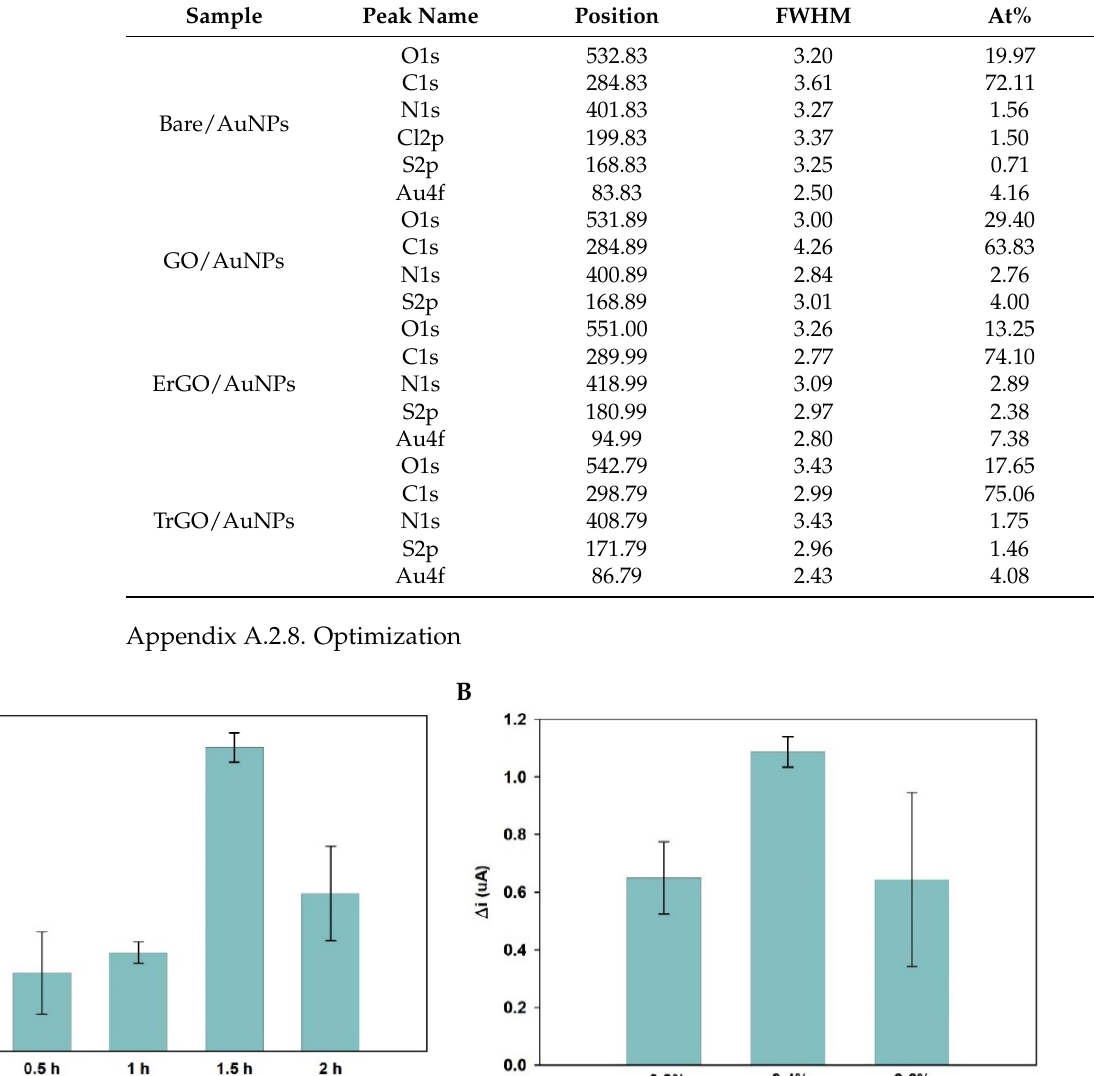
Figure A6. SEM images of ErGO ( A ) and ErGO/AuNPs ( B ) electrodes. EDS spectra of the ErGO ( C ) and ErGO/AuNPs ( D ) electrodes. The inset tables show the present elements, the relative concen- tration (Wt%) of each element, and their measurement errors ( σ ).